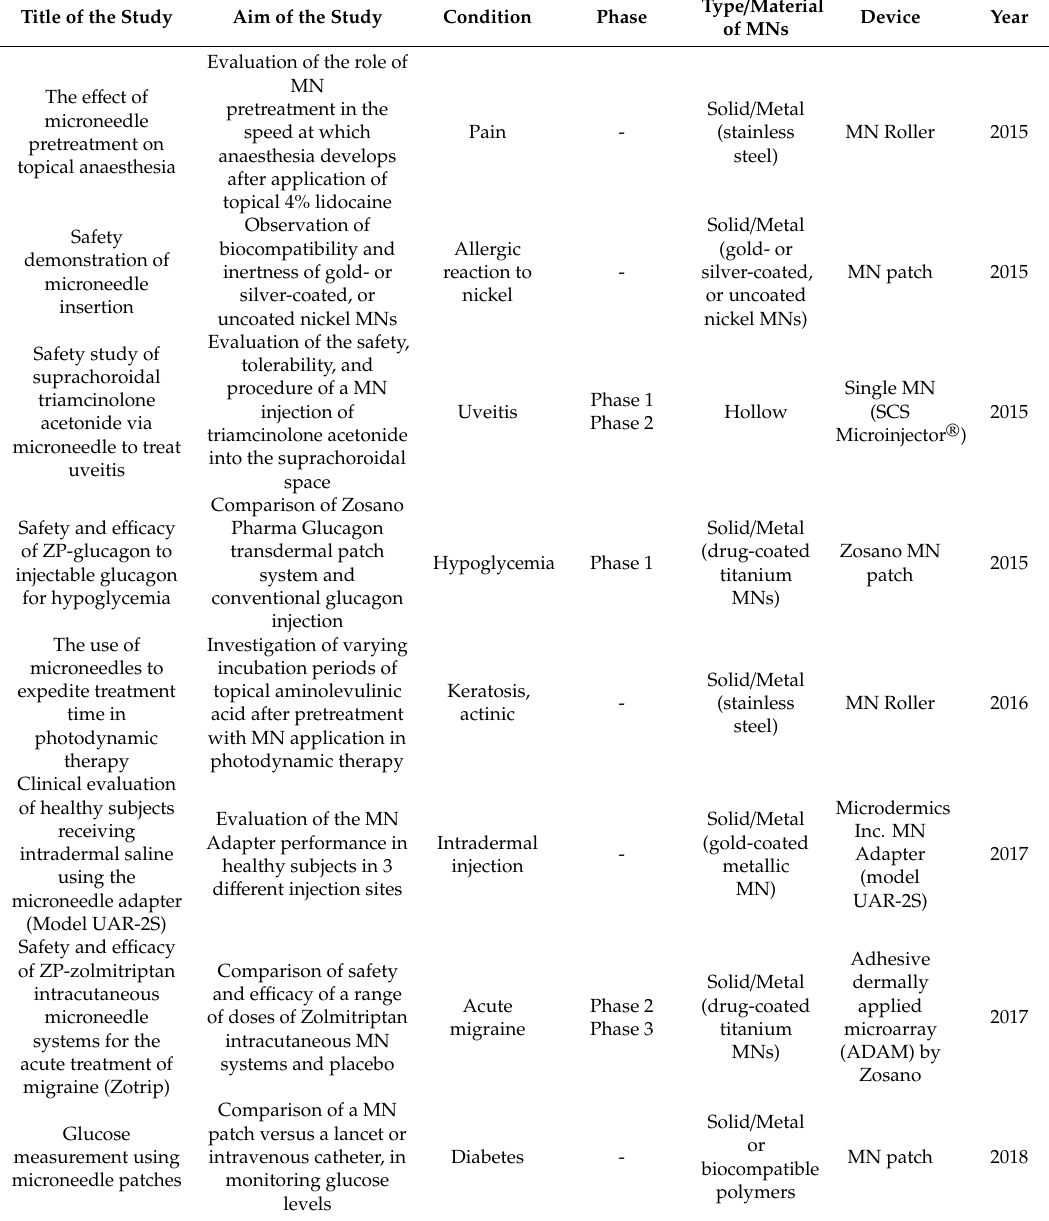
Table 2. MNs in completed clinical trials